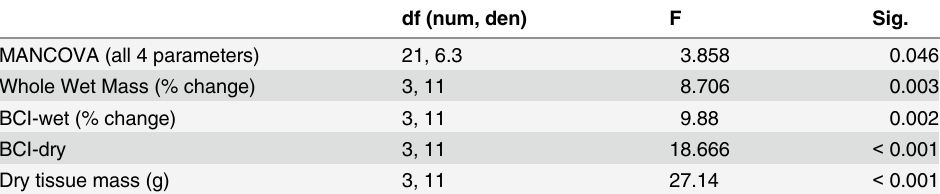
Table 7. Results of MANCOVA and ANCOVA tests on A . plicata data. df (num, den) F Sig. MANCOVA (all 4 parameters) 21, 6.3 3.858 0.046 Whole Wet Mass (% change) 3, 11 8.706 0.003 BCI-wet (% change) 3, 11 9.88 0.002 BCI-dry 3, 11 18.666 < 0.001 Dry tissue mass (g) 3, 11 27.14 < 0.001 Tests on whole wet mass and BCI-wet were performed on the percent change from pre- to post-exposure measurements. Tests on BCI-dry and dry tissue mass were performed on data collected post-mortem. MANCOVA was analyzed using all four measured parameters as dependent variables. Both MANCOVA and ANCOVA tests were run with the average pre- and post-exposure mussel whole wet mass as